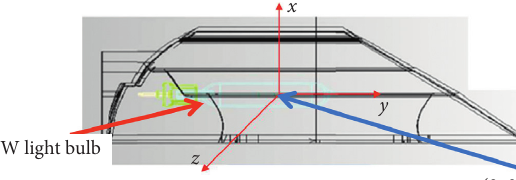
Figure 8: The metal halide light bulb fixed in the freeform-surfaced luminaire. The bulb emitting region was initially placed at the origin (0, 0, 0), set in the center of the